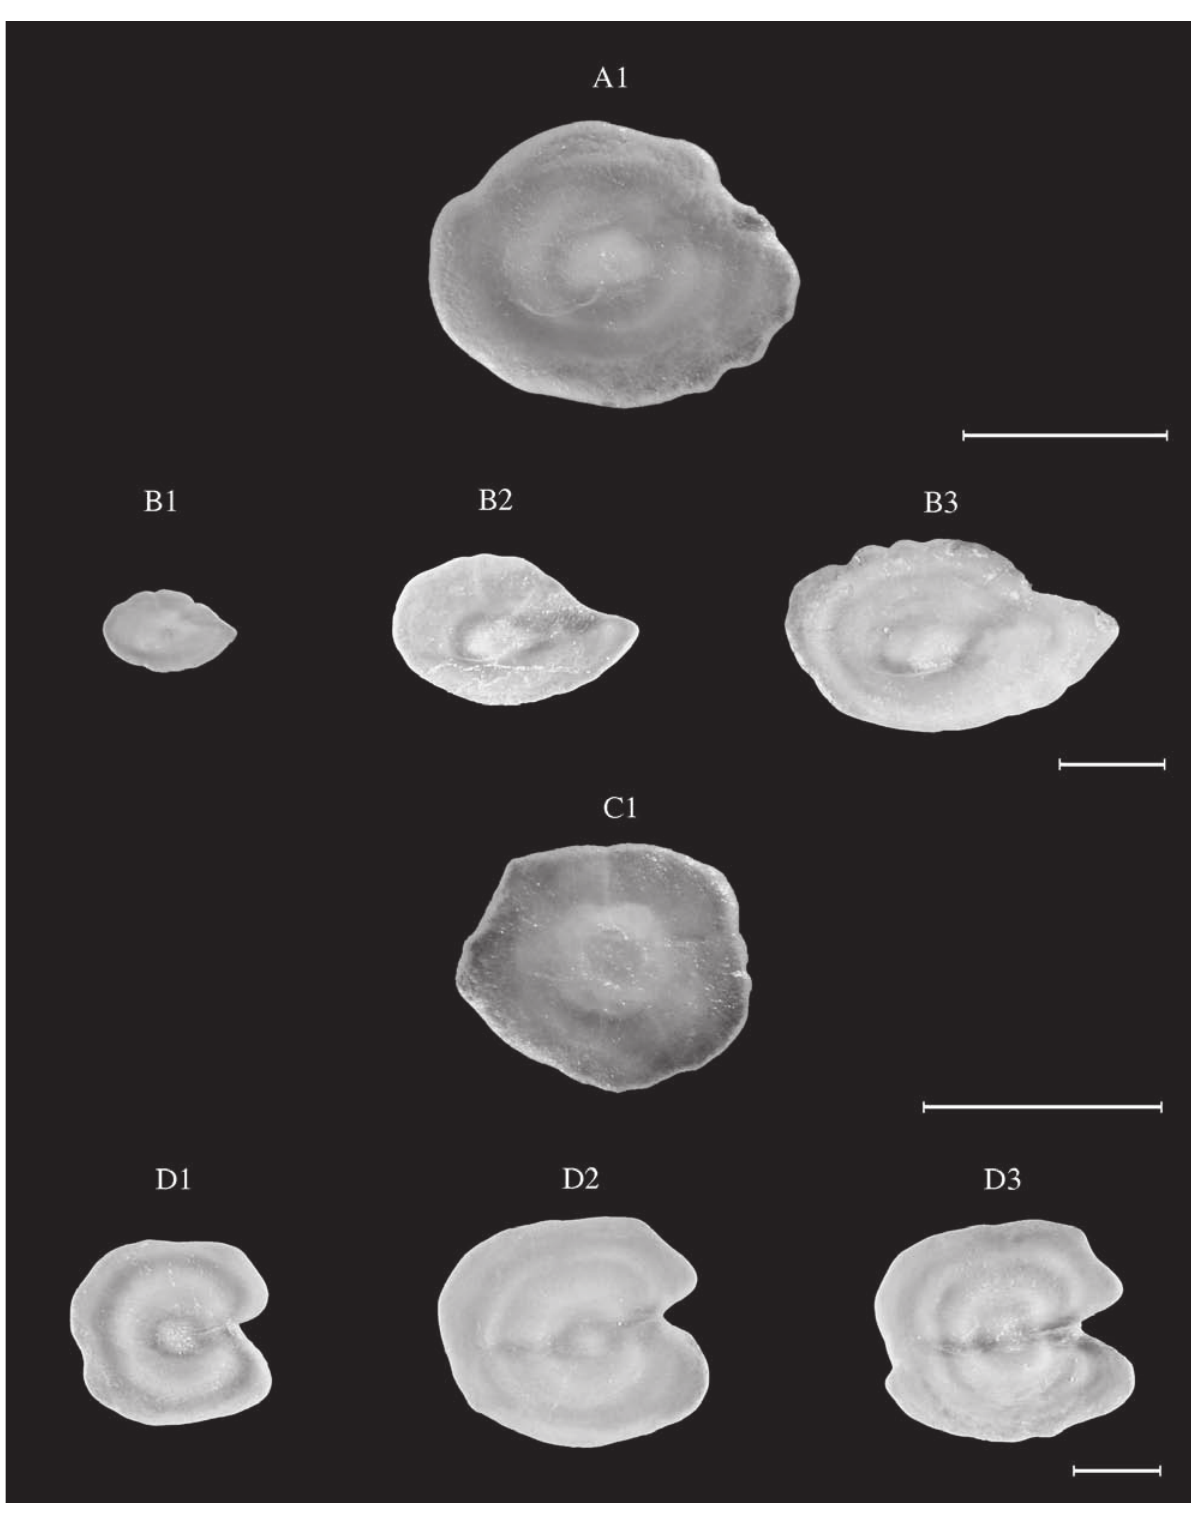
Fig. 22. – Bolinichthys indicus (NEA). TL: A1, 4.5 cm. Ceratoscopelus maderensis . TL: B1, 3.6 cm (NEA); B2, 5.5 cm (WM); B3, 7.5 cm (WM). Gonichthys cocco (NEA). TL: C1, 5.0 cm. Lampanyctus crocodilus (WM). TL: D1 11.0 cm; D2, 13.6 cm; D3, 14.5 cm. Scale bar = 1